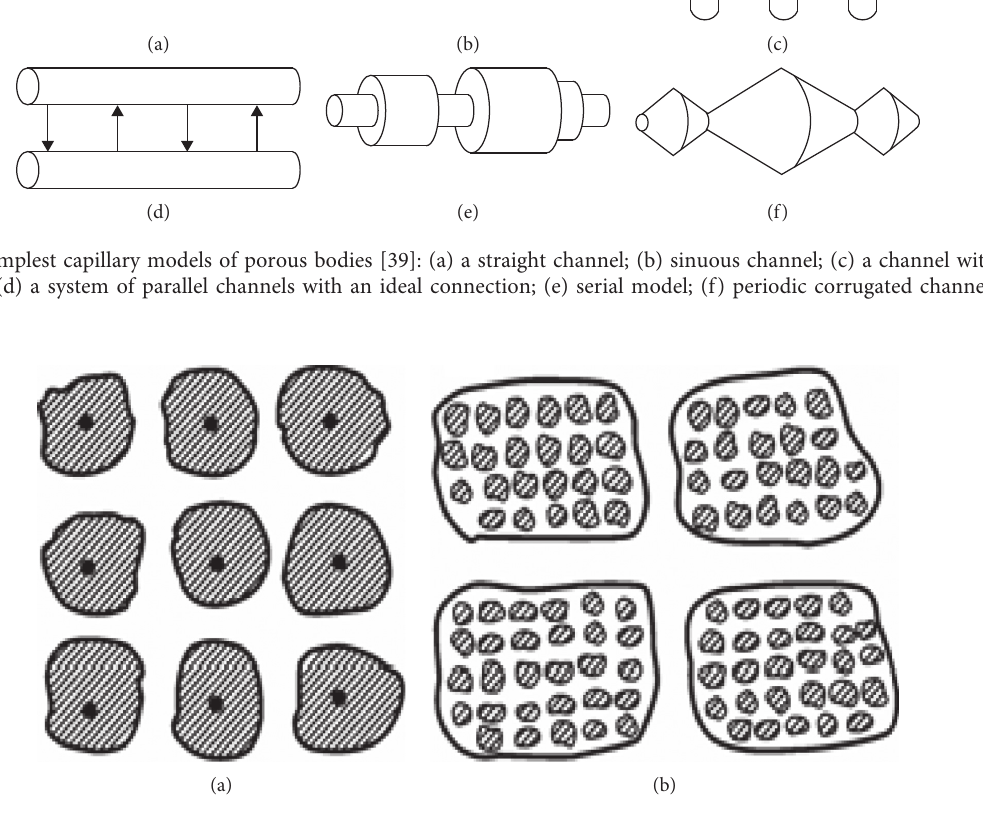
Figure 3: Lattice regular models of porous media [39, 41]: (a) the system of particles at the lattice sites; (b) ‒ bidisperse model.